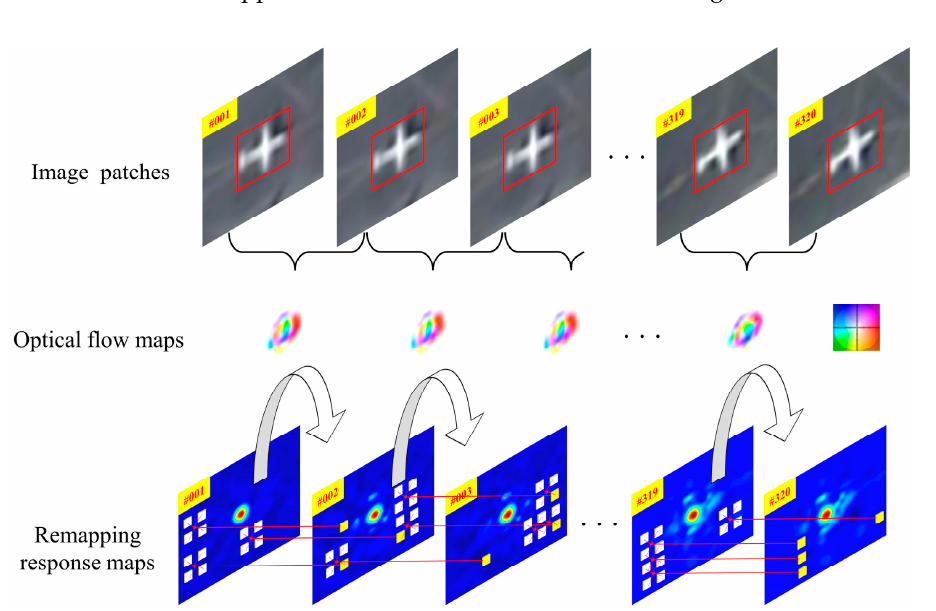
Figure 4. Visualization of the optical flow remapping process. In the last row, each pixel of the target response map is traversed to calculate its corresponding position in the previous response map. If the position does not exist, the values of its neighboring pixels will be interpolated to determine the pixel value in the target response map.